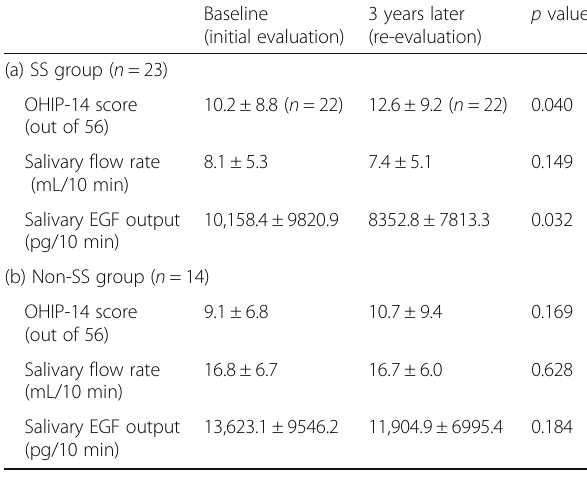
Table 4 Clinical characteristics at baseline (initial evaluation) and at re-evaluation 3 years later Baseline 3 years later (initial evaluation) (re-evaluation)